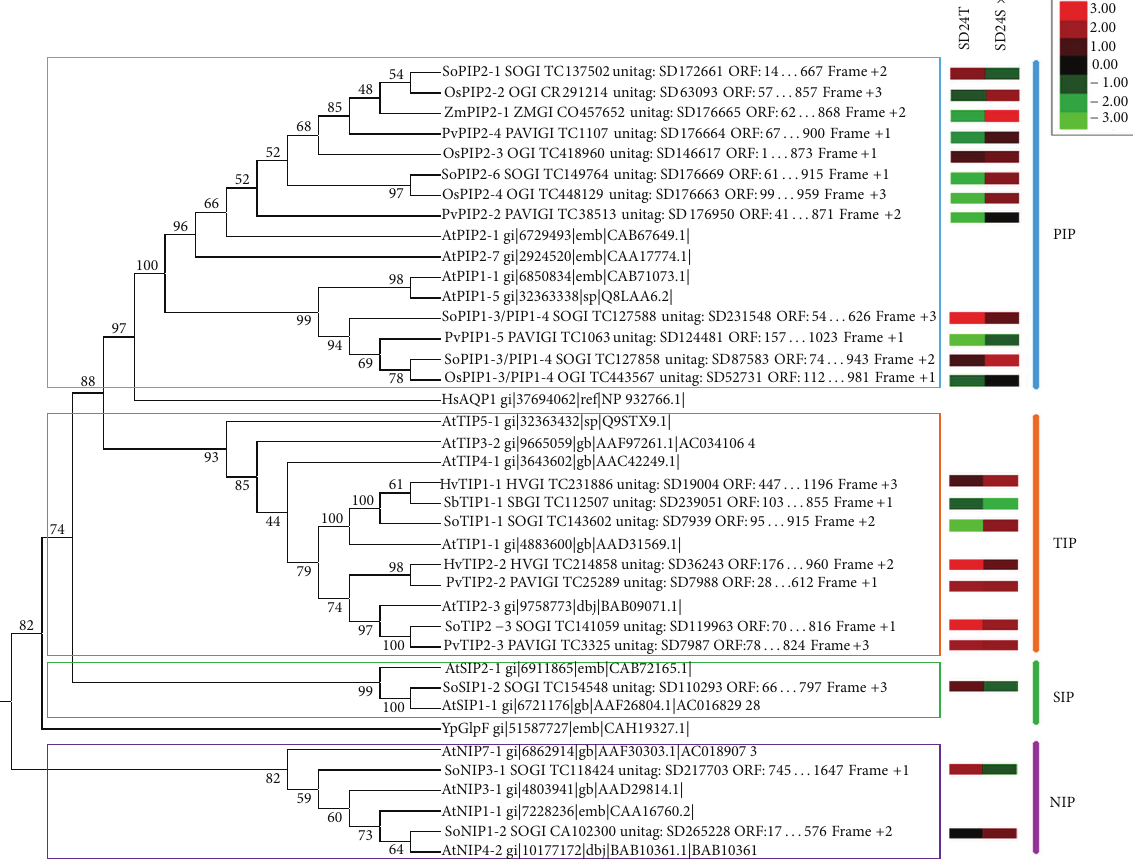
Figure 2: Neighbor Joining dendrogram (MEGA v.5.2.1 software [27]) and integrated heat map (bootstrap values of 1,000 replications), showing the phenetic grouping of 24 potential aquaporin amino acid sequences identified by HT-SuperSAGE unitags from sugarcane accessions after 24h of continuous dehydration (with their respective EST and unitag identifiers), and aquaporins sequences of Arabidopsis thaliana , human and Yersinia pseudotuberculosis (all these labeled by an asterisk). Nomenclature: Isoforms are preceded by the abbreviated species name ( At-Arabidopsis thaliana; Hs-Homo sapiens; Hv-Hordeum vulgare; Os-Oryza sativa; Pv-Panicum virgatum; Sb-Sorghum bicolor; So-Saccharum officinarum; Yp-Yersinia pseudotuberculosis; Zm-Zea mays